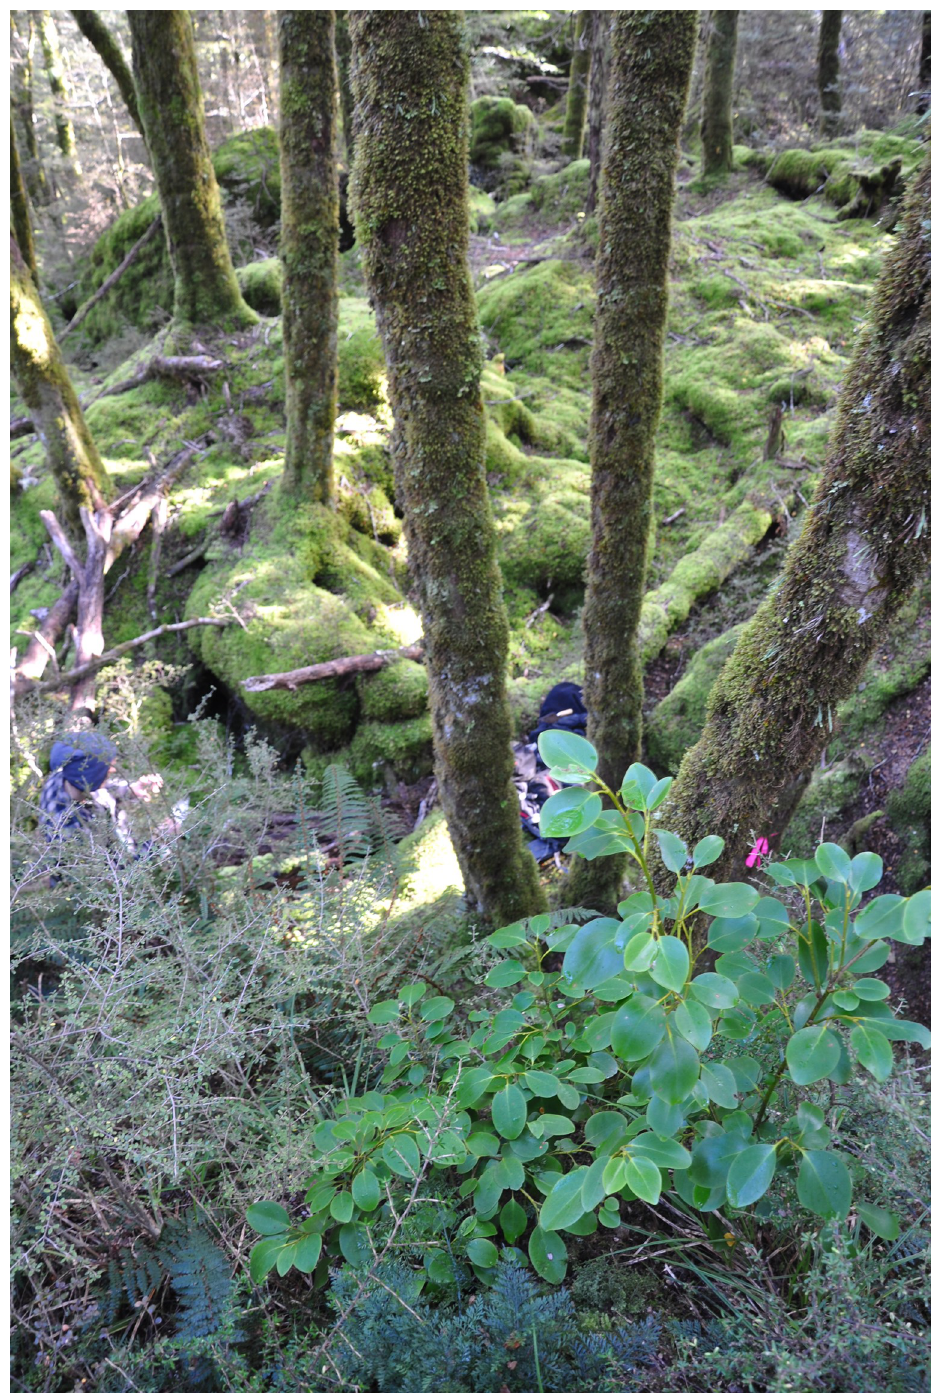
Fig 8. View from top of large boulder inaccessible to deer, Daley’s Flat rock avalanche deposit. A dense and species-rich patch of plants in the foreground (including Coprosma spp., Griselinia , Carex , Asplenium , Hymenophyllum , Polystichum and Notogrammitis ) contrasts with the sparse forest understorey in the presence of deer in the background (mainly Fuscospora trees and mosses).